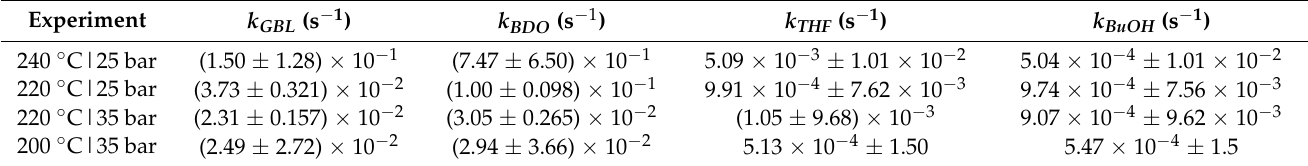
Table 6. Estimated kinetic parameters and their uncertainty for a 97.5% confidence interval for Model